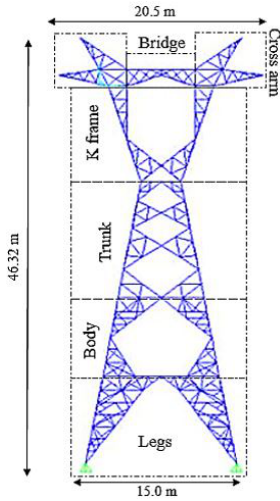
Figure 4. Geometry and dimensions of the case study tower.